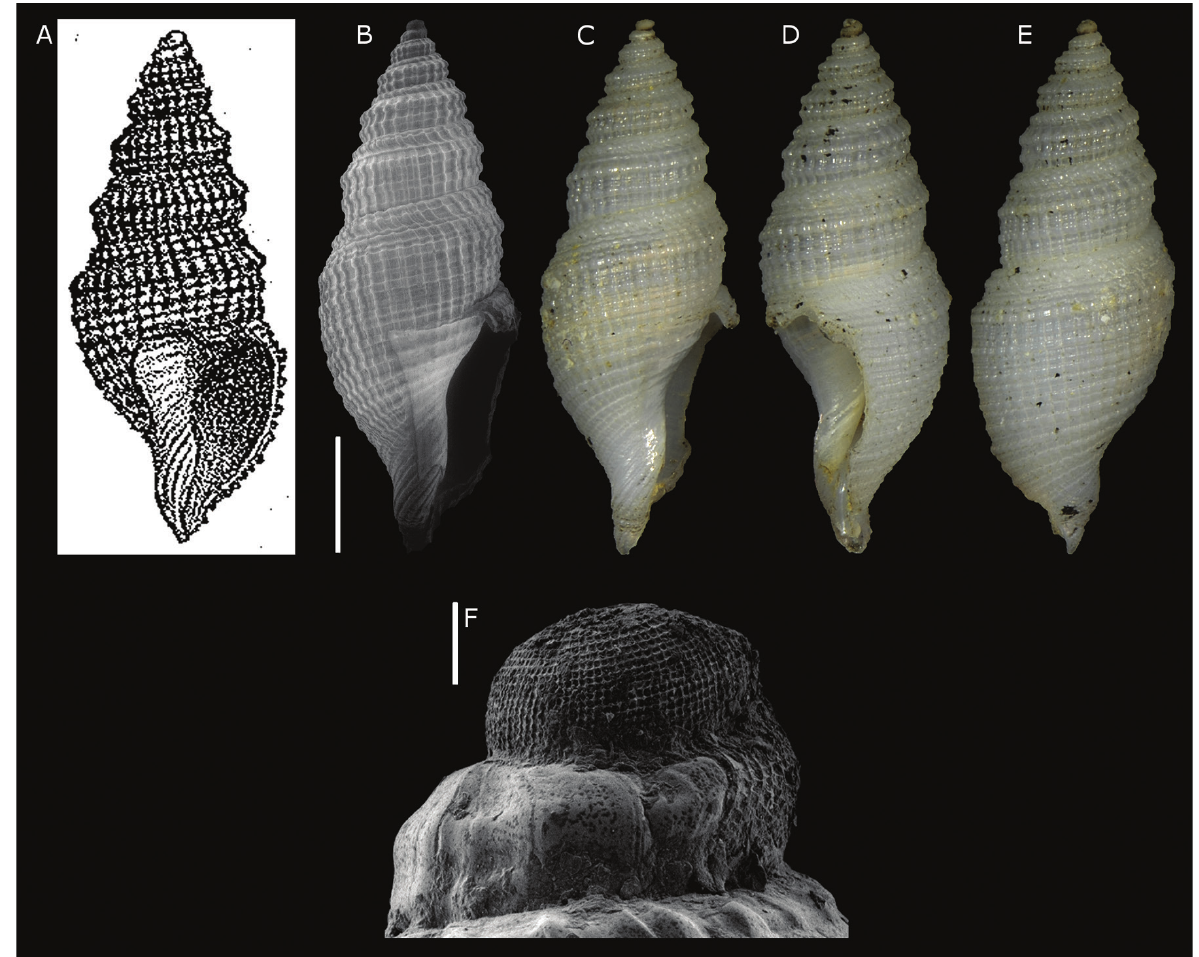
Figure 28. Pleurotoma beblammena Sturany, 1903, Station 143 (Harmil Island, Dahlak Archipelago, Eritrea, Red Sea). A . Original figure by Sturany (1903). B–F . Holotype, NHMW 84256: front ( B–C ), right side ( D ), back ( E ), protoconch ( F ). Scale bars: B–E : 2 mm, F : 0.1 mm.